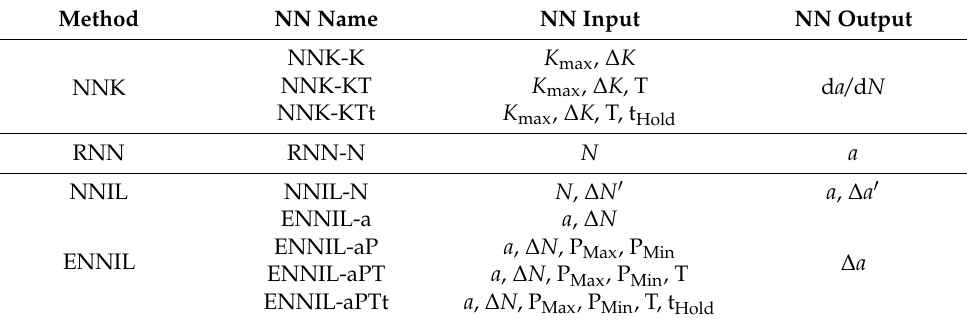
Table 3. List of NN-based methods for predicting CG at elevated